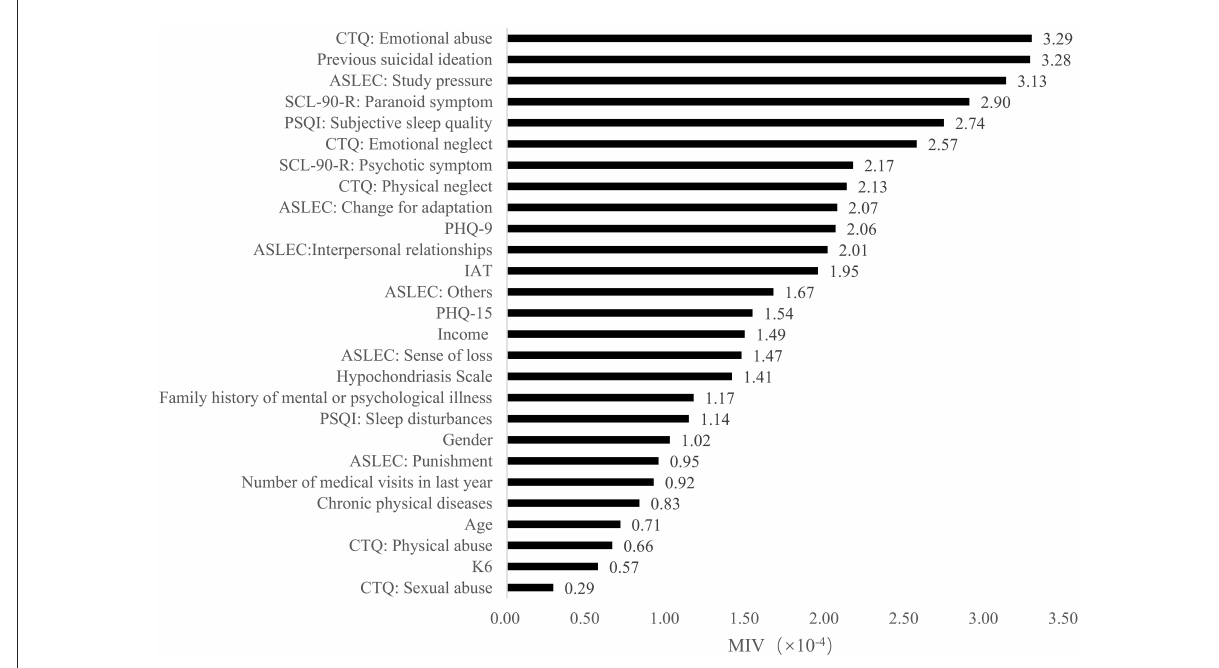
FIGURE2 The mean impact values of independent variables in model